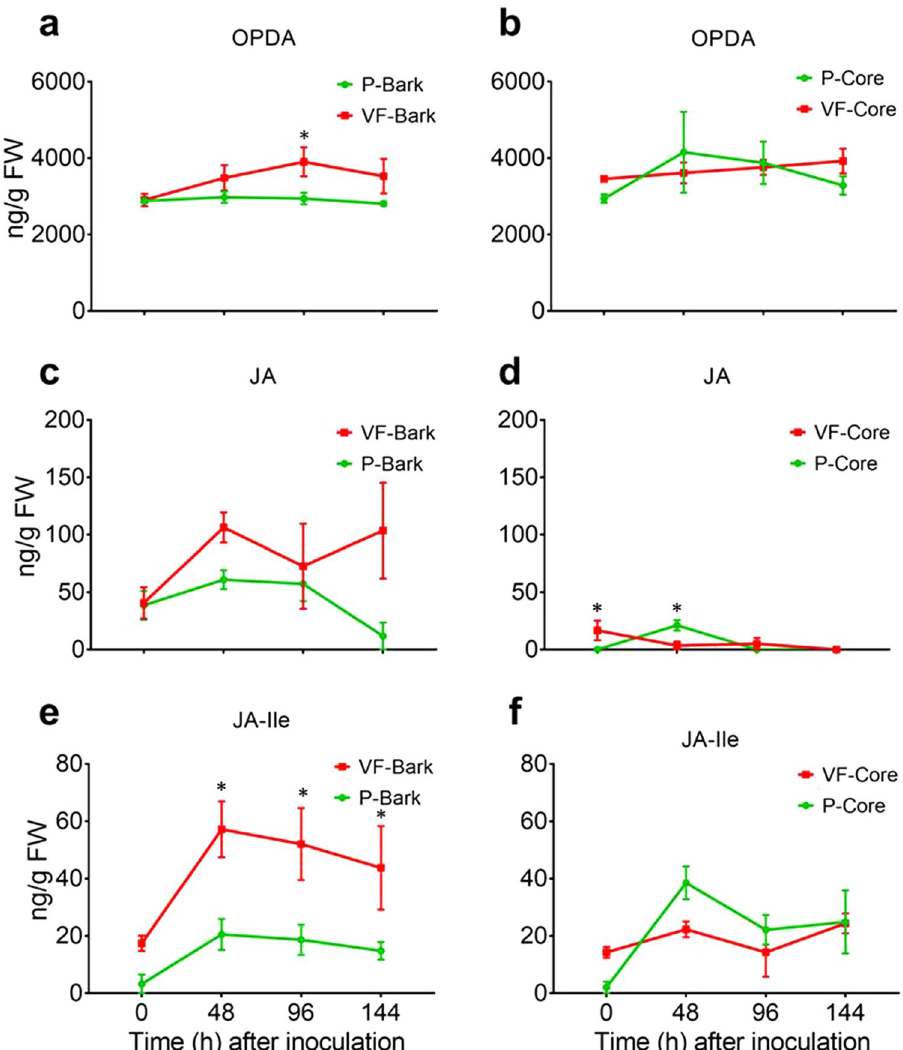
Figure 4. Levels of jasmonates in the inoculated stem tissues of ‘Valley Forge’ and ‘Princeton’. ( a–f ) The level of 12-oxo phytodienoic acid (OPDA), jasmonic acid (JA) and JA- isoleucine (JA-Ile), respectively, in the bark ( a , c , e ) and core ( b , d , f ) tissues of ‘Valley Forge’ (VF) and ‘Princeton’ (P) at different time points of inoculation with the O . novo-ulmi (MH75-4O). The results are the mean ± SE of three biological replicates. Values marked with an asterisk ( * ) are significantly higher than the control sample (P-bark at 0 hpi) and the corresponding time point in the other genotype ( P <